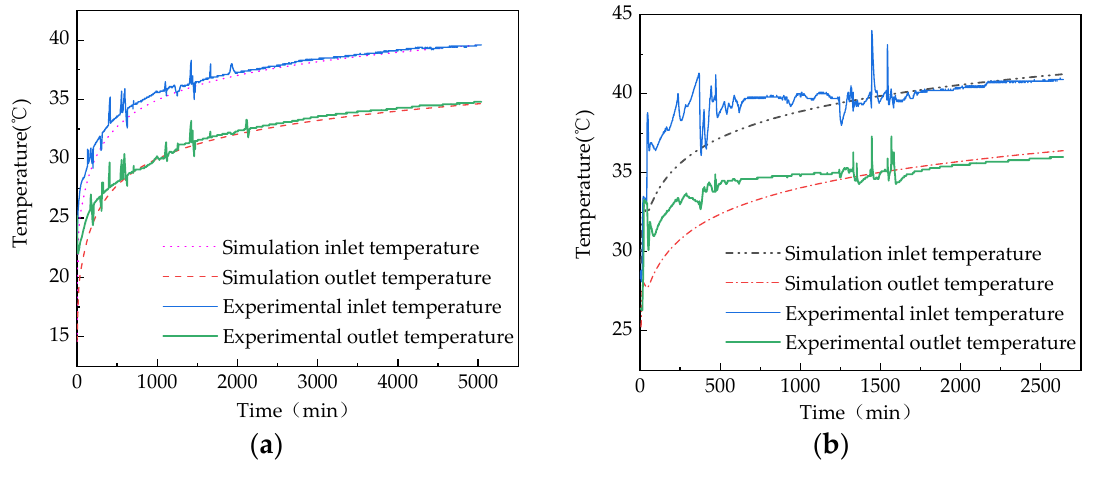
Figure 13. Comparison of the inlet and outlet temperatures under different circulation modes. ( a ) The “inner tube in and outer tube out” configuration. ( b ) The “outer tube in and inner tube out” configuration.